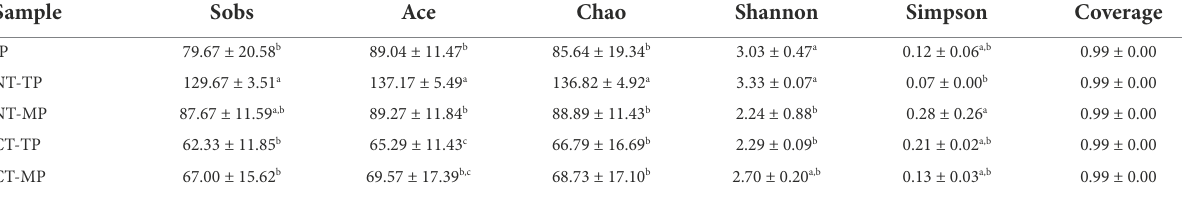
Data are presented as mean ± standard deviation (SD). Different lowercase letters indicate a significant difference at p < 0.05 level (Duncan’s new multiple range test). NT and CT represent normal and continuous thermophilic composting, respectively; IP, TP, and MP represent the initial, thermophilic, and mature phases, respectively.